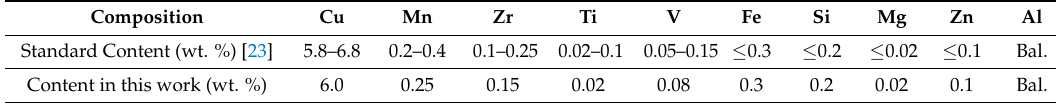
Table 1. The chemical compositions of the 2219 Al alloy (wt.